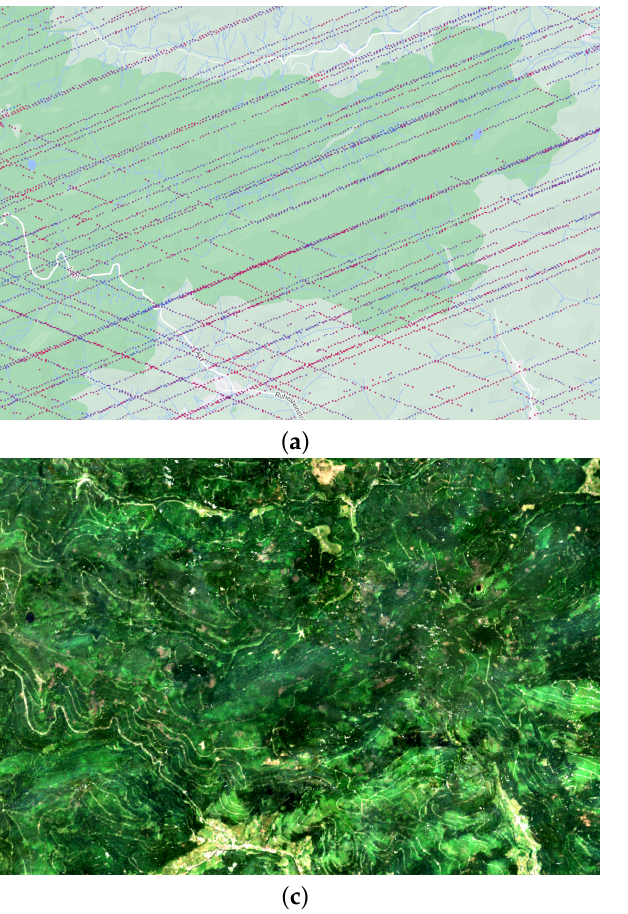
Figure 1. Satellite imagery downloaded using Google Earth Engine over the same location in Black Forest, Germany [centre point: 48.528N, 8.228E]. ( a ) Lidar, GEDI. Footprints of data are shown by coloured dots ranging from pink (low height) to blue (large height). ( b ) SAR HV, ALOS PALSAR- 2 annual mosaic, shown with no filtering. No backscatter is black and high backscatter is white. ( c ) Optical Imagery, Sentinel-2. Bands 2, 3 and 4 are shown to create a RGB image, with a 90% stretch applied. ( a ) GEDI footprint data, lidar imagery; ( b ) ALOS-PALSAR-2 annual mosaic, SAR imagery; ( c ) Sentinel-2 bands: RGB, optical